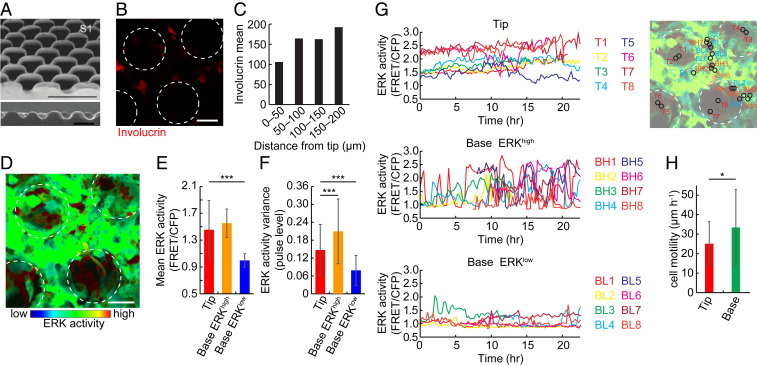
Spatial segregation of ERK activity patterns on topographical substrates. (A) Top (Upper) and cross-section (Lower) SEM images of the patterned PDMS substrate. Reproduced from a previous publication (39). (Scale bars: 400 μm [Upper] and 500 μm [Lower].) (B) Involucrin-mCherry expression on the patterned PDMS substrate. White dotted circles: tips of the substrate. (Scale bar: 100 μm.) (C) Mean Involucrin-mCherry expression in regions at different distances from the tips. (D) Representative image of ERK activity in human keratinocytes cultured on the PDMS substrate. Colors indicate ERK activity. White circles: tips of the substrate. (Scale bar: 100 μm.) (E and F) ERK (E) activity mean and (F) pulse levels of cells cultured on patterned substrates. Data are mean ± SD (n = 50 tip cells, 27 base ERKhigh cells, and 23 base ERKlow cells, two-tailed unpaired Student’s t test; P values are indicated by ***P < 0.001). (G) (Left) Representative time series of human keratinocytes on tip regions (Upper) and base regions (troughs) with high (Middle) and low (Lower) ERK activity. Eight time series are shown for each group. The locations of the cells are mapped on the image to Right. (H) Motility of cells at the tip and base. Data are mean ± SD (n = 45 tip cells, 50 base ERKhigh cells, two-tailed unpaired Student’s t test; P values are indicated by *P < 0.05).